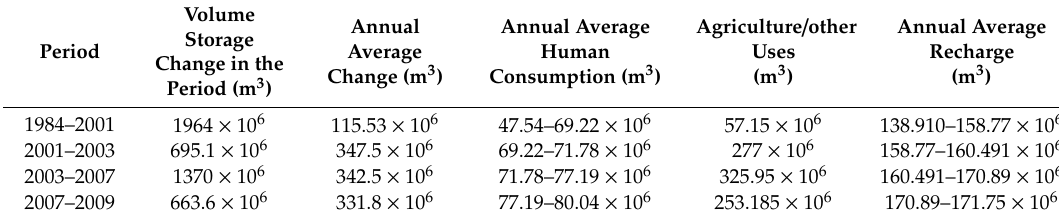
Table 16. Extracted volume in different periods (volume storage change)